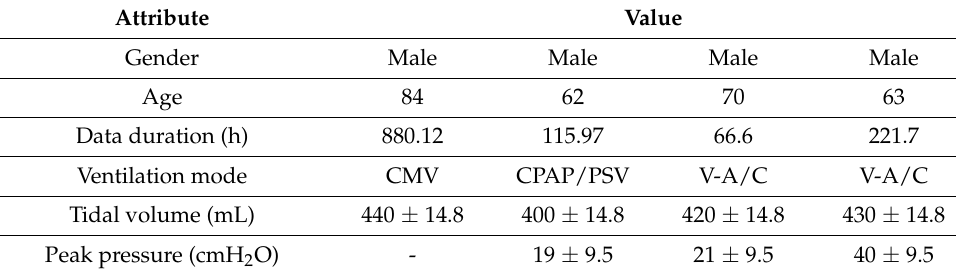
Table 1. Basic information and monitoring information of 4